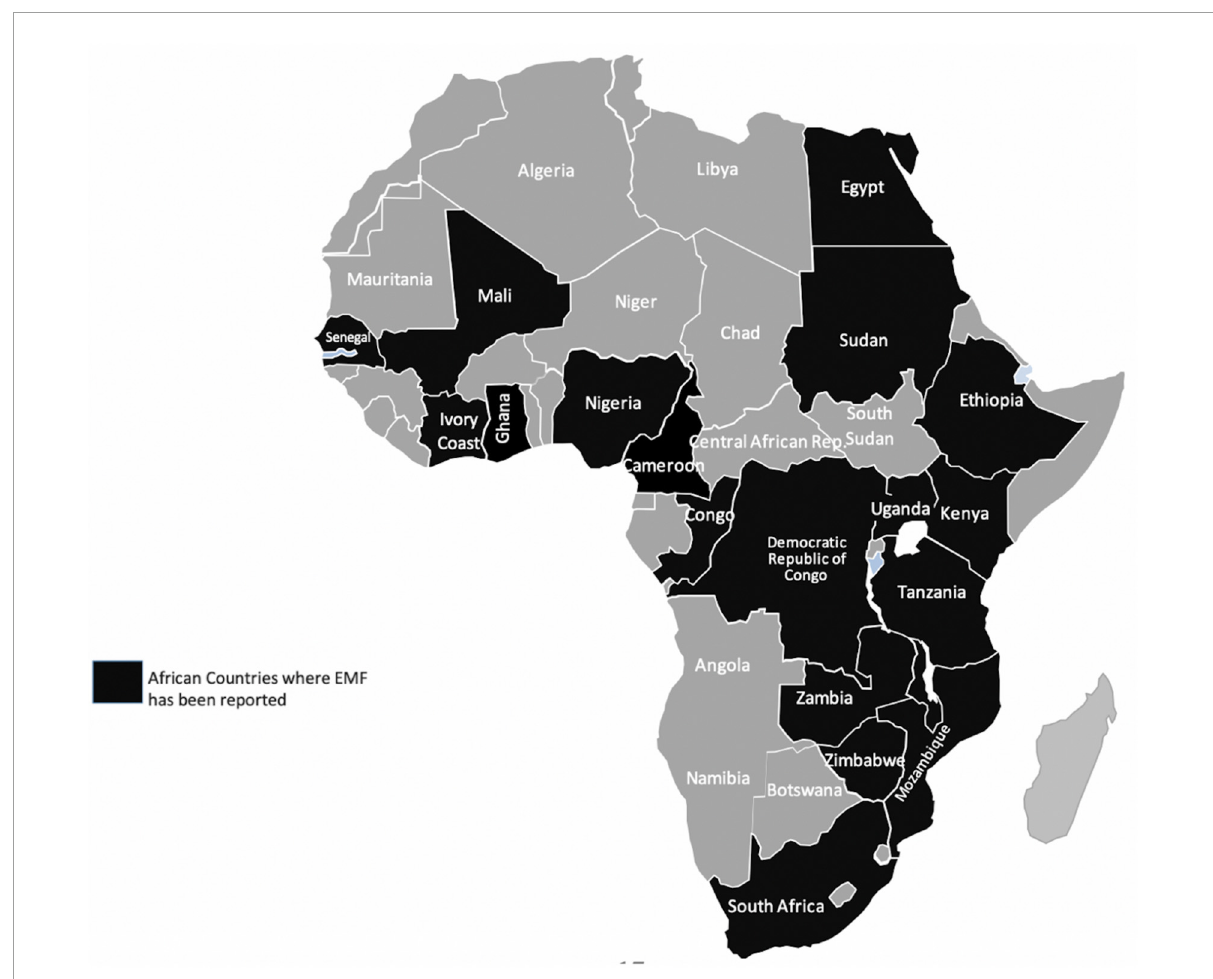
FIGURE5 Countries in Africa where Endomyocardial fibrosis (EMF) has been described previously. Data extracted from Mocumbi et al.